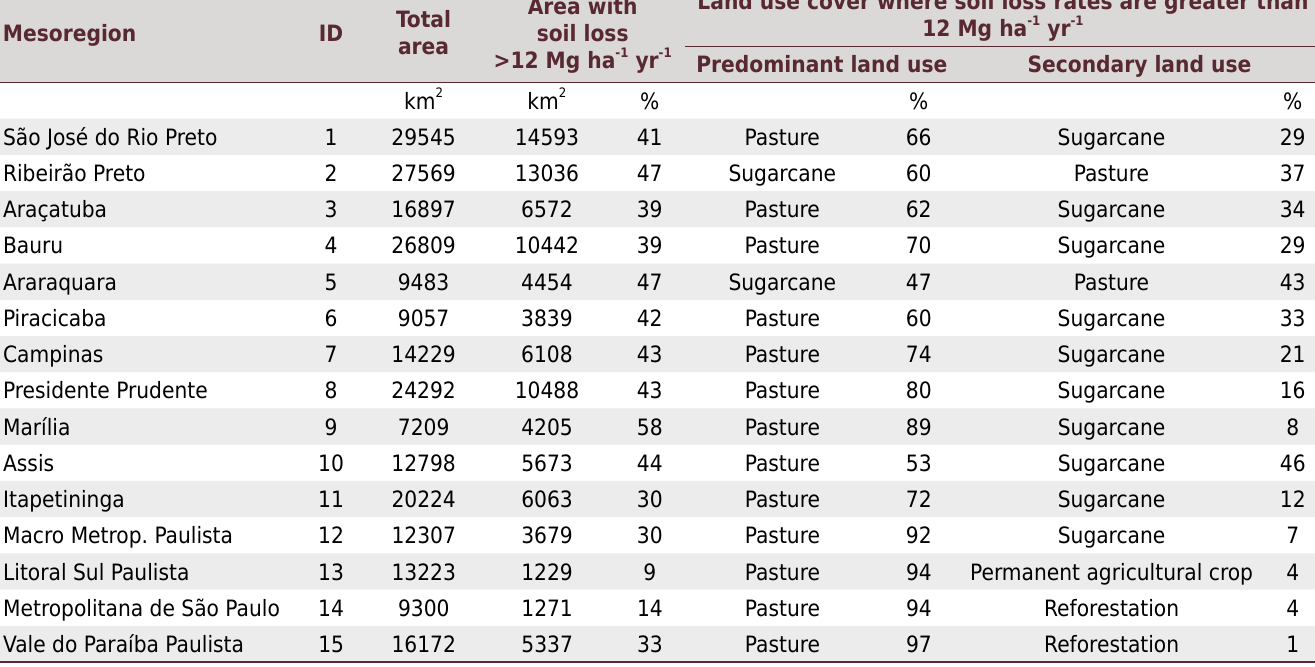
Table 2. Quantity of areas with land use cover where the estimates of soil loss rates are greater than the average rate of soil loss tolerance of 12 Mg ha -1 yr -1 Mesoregion ID